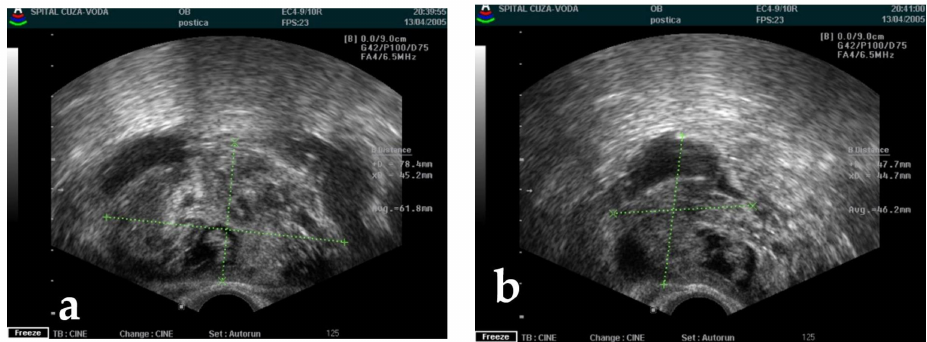
Figure 3. Ultrasonography showing a predominantly hyperechoic heterogenous ovarian mass. ( a ) Longitudinal view; ( b ) Transverse view.